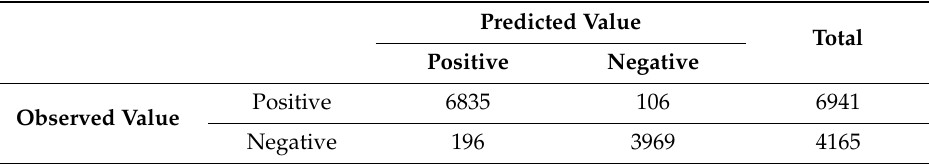
Table 4. The confusion matrix of the branch implemented by feature library matching.